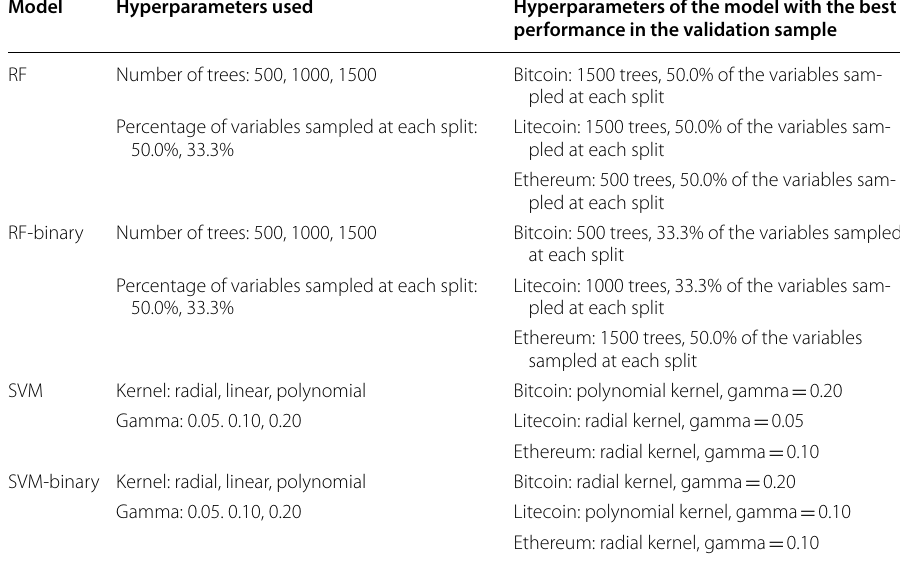
This table presents all combinations of hyperparameters used in the experiments. The hyperparameters of the model with the best performance in the validation sample were then used to define the trading strategies in the test sample. For Random Forests (RF), the remaining hyperparameters were kept at the defaults of the randomForest R package. For Support Vector Machines (SVM), the remaining hyperparameters were kept at the defaults of the e1071 R package